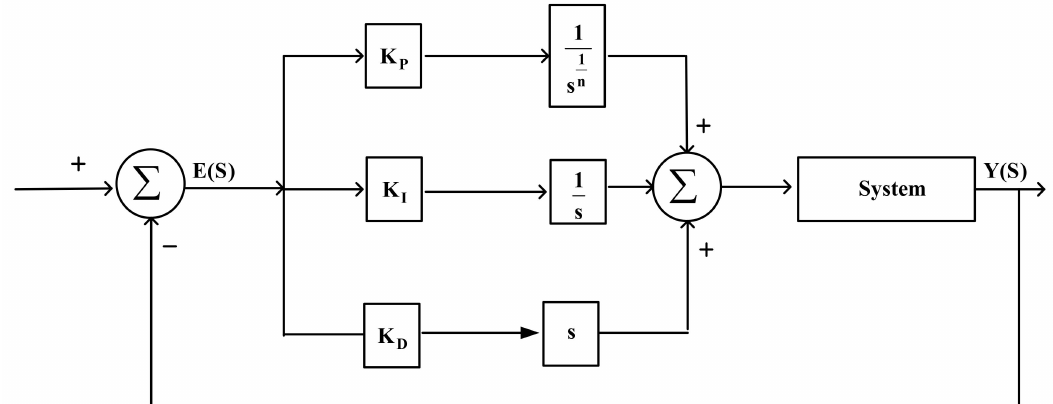
Figure 3. Structure of a TID